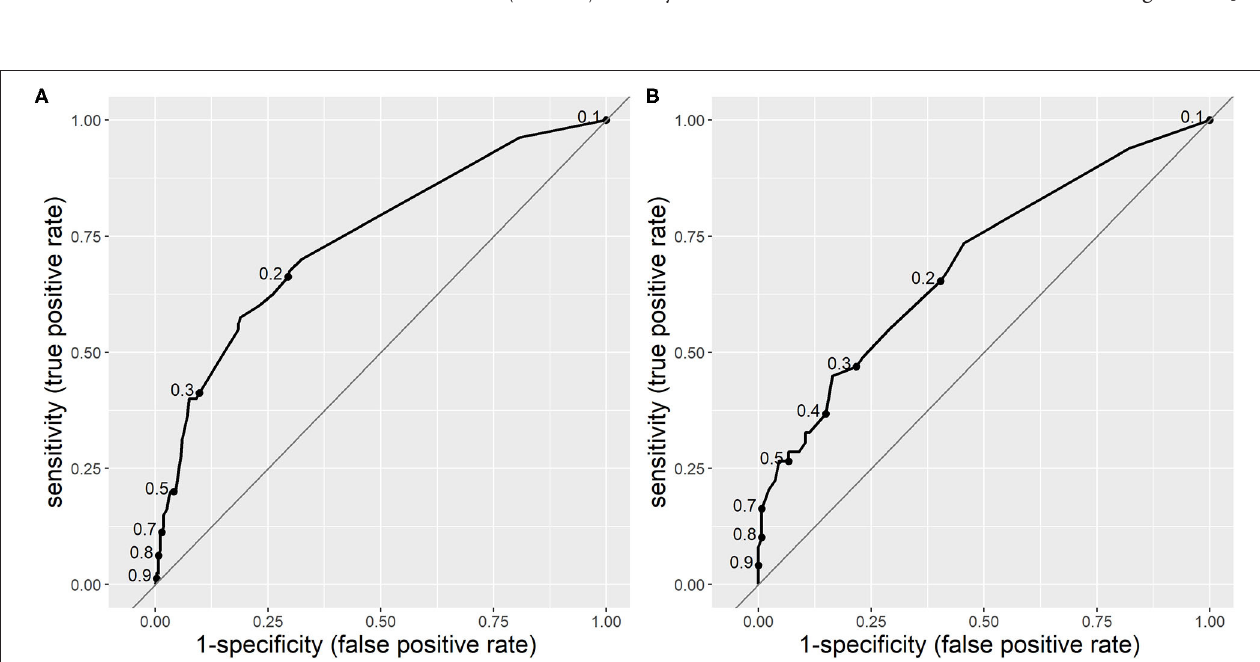
FIGURE 1 | Receiver operating characteristic curves of clinical prediction model 1 (CPM 1) for risk of serious bacterial infections (SBIs) in derivation (A) and validation (B) populations. The dots on the curves represent sensitivity and specificity at different cut-off points.